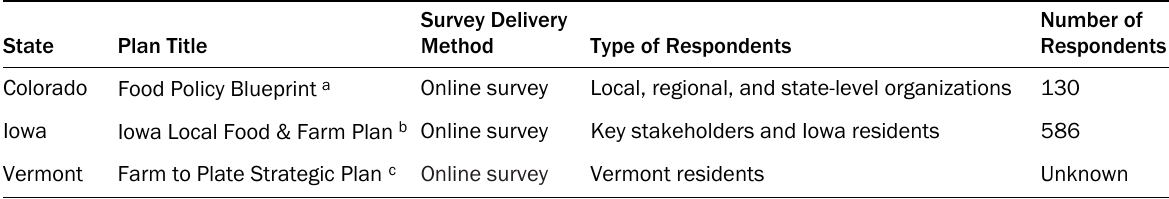
Table 1. Use of Surveys in the Colorado, Iowa, and Vermont Food System